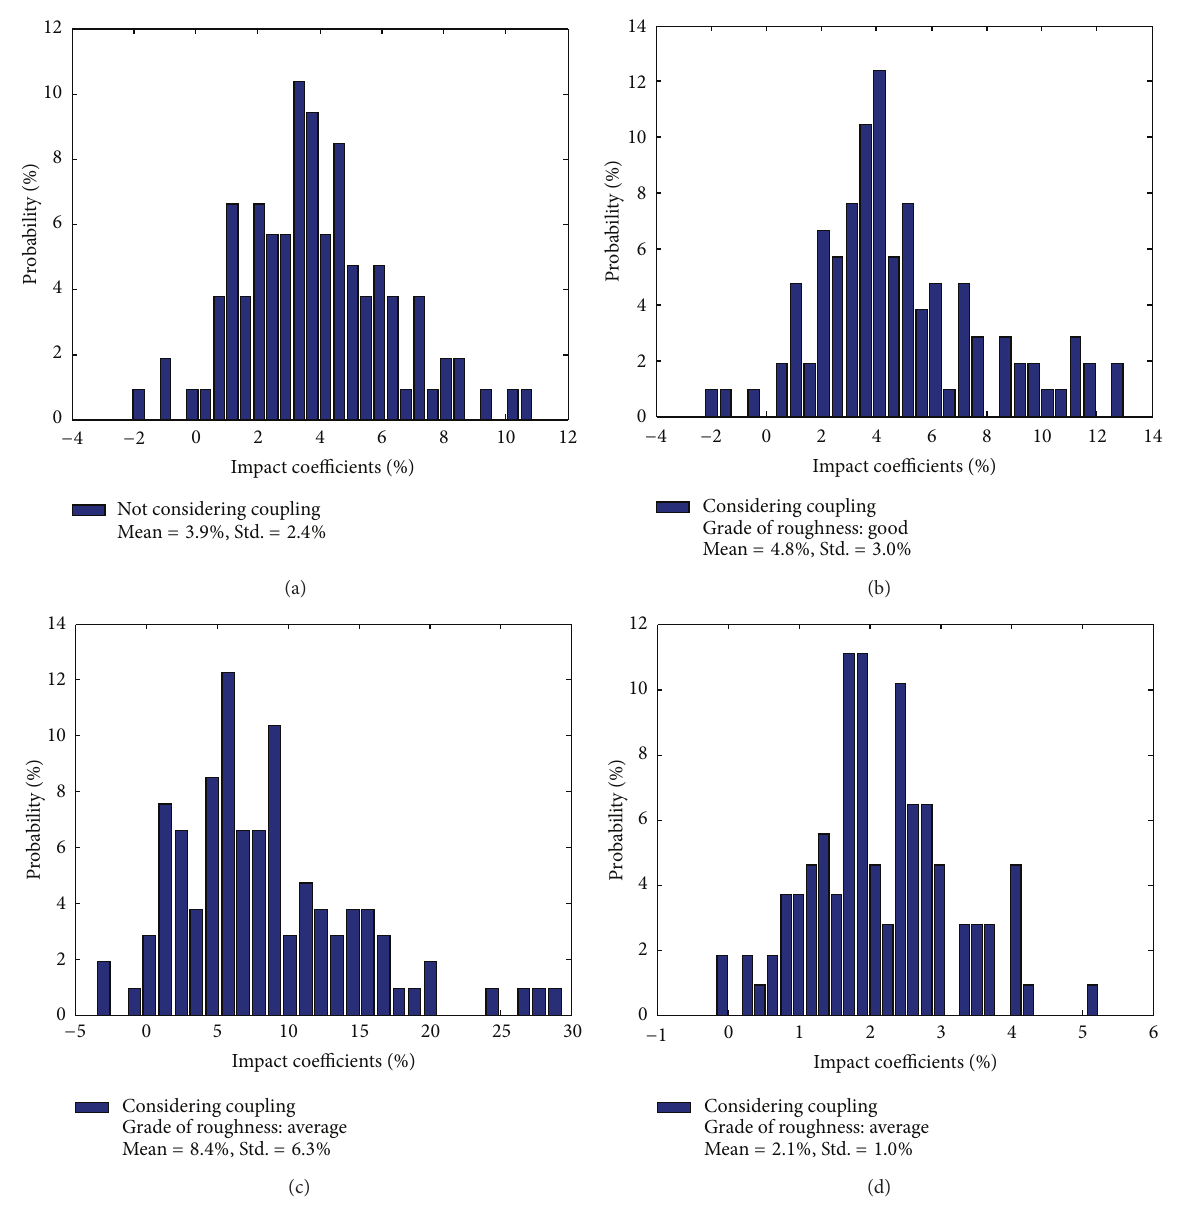
Figure 13: Probabilistic distributions of vertical displacement impact coefficients of the bridge under the conditions of different surface roughness: (a) at point A; (b) at point A; (c) at point A; (d) at point